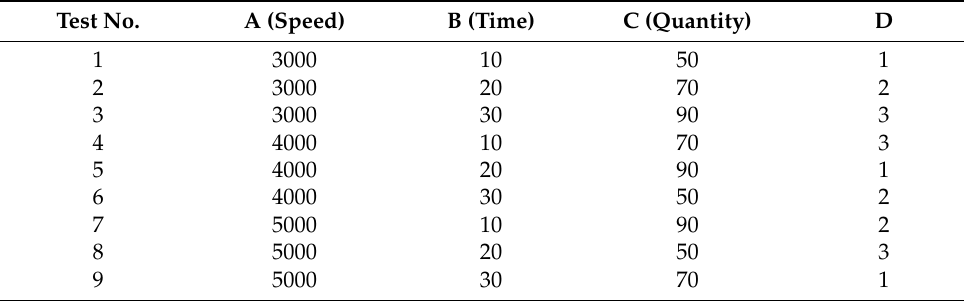
Table 1. Orthogonal experiment table L9 (3 4